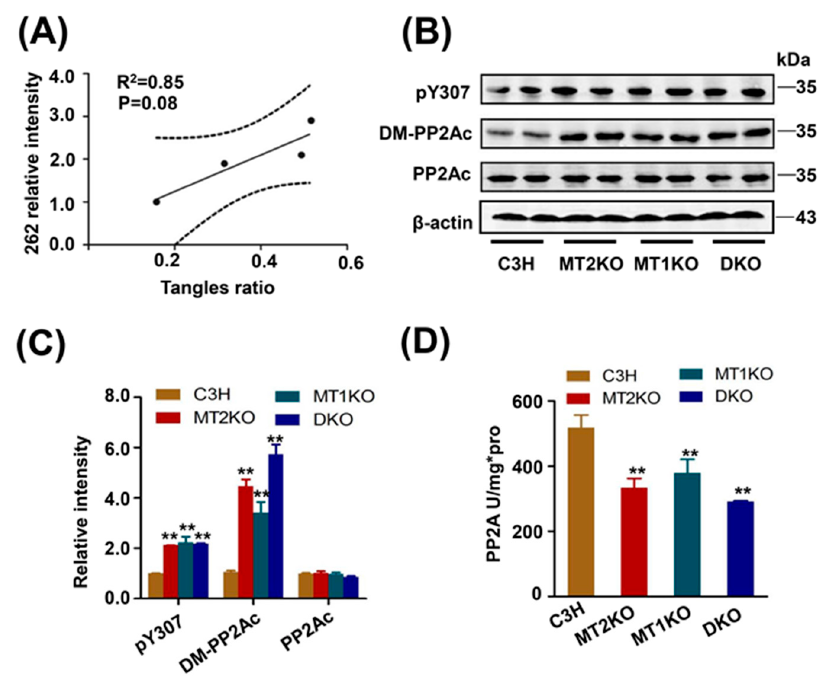
Figure 3. Decreased activity of PP2A in the three transgenic mice. ( A ) Linear regression conducted between pS262 and tangle ratio. ( B ) Western blotting of pY307-PP2Ac, DM-PP2Ac and PP2Ac. ( C ) Relative quantity of pY307-PP2Ac, DM-PP2Ac and PP2Ac. ( D ) Detecting the activity of PP2A by ELISA. ** p < 0.01, compared with C3H. Data are presented as means ± SD. PP2A: protein phosphatase 2A. DM-PP2Ac: demethylation of PP2Ac.